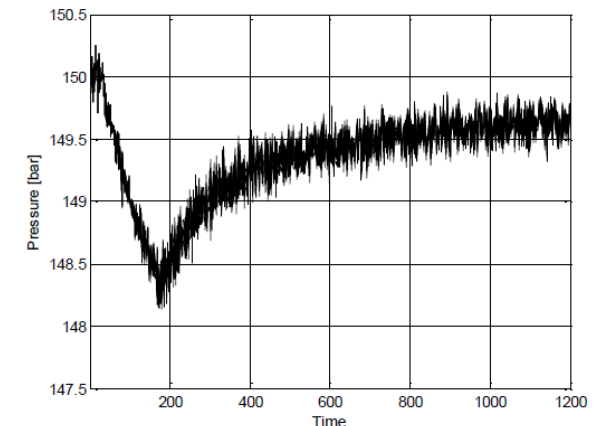
Fig. 18. Pressure profiles of trajectories belonging to cluster 1.